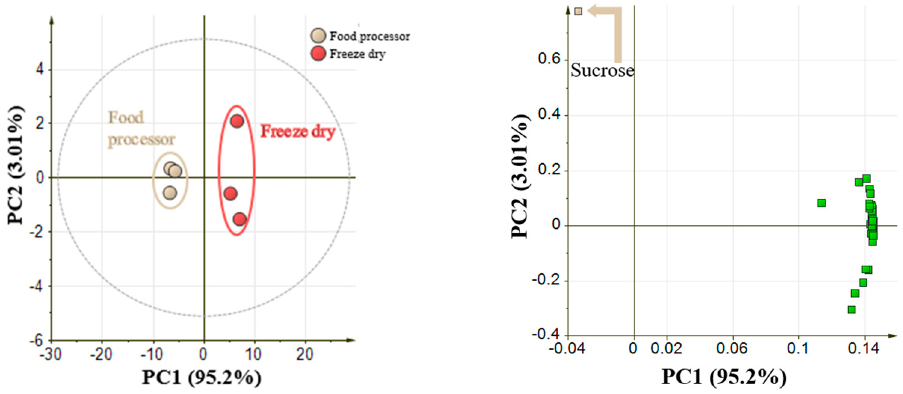
Figure 2. PCA of comparison of different sample preparation methods: Food processor method and freeze-drying method. 47 annotated metabolites from GC-MS analysis were auto-scaled prior to PCA. (Left: Score plot between food processor and freeze dry samples; Legends represent the samples and colored as follow: food processor: light brown circle, freeze dry: red circle. Right: Loading plot shown almost all metabolites (except sucrose shown by light brown arrow) showed higher accumulation by freeze-dry method).